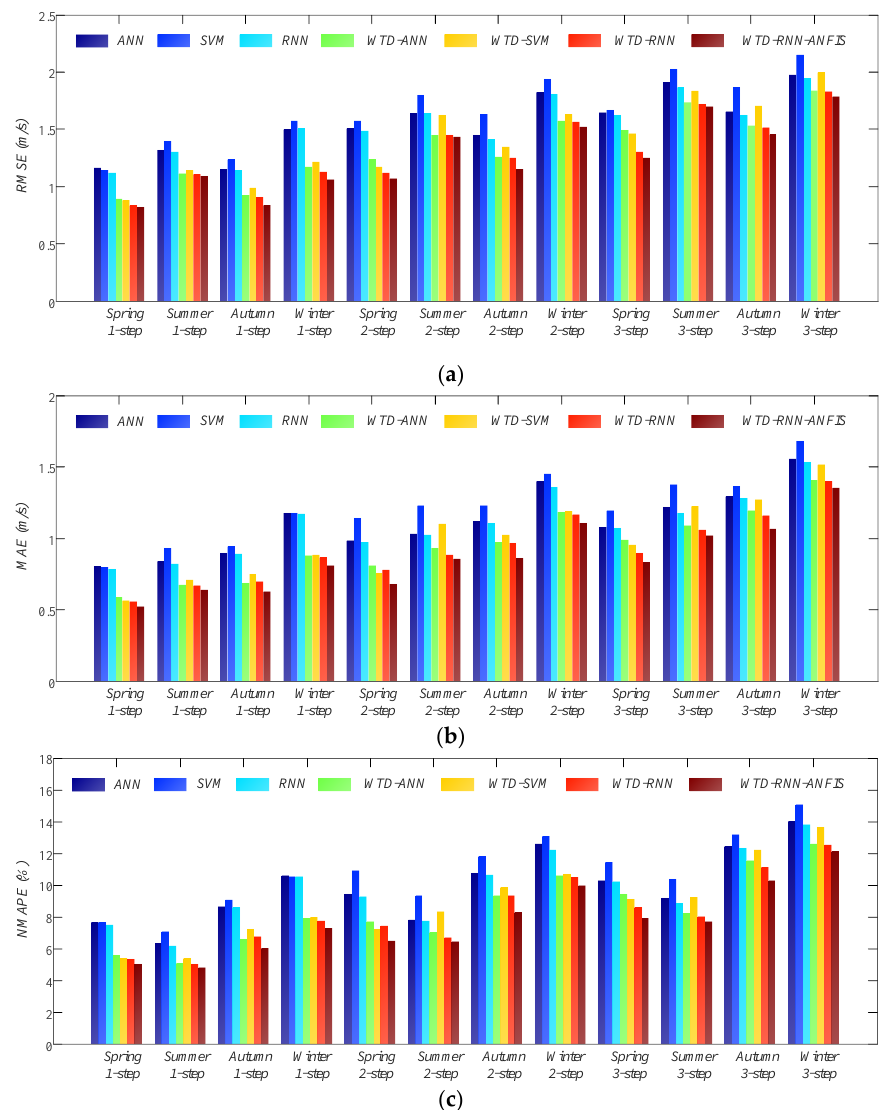
Figure 10. The comparisons of performance criteria for point wind speed forecasting. ( a ) RMSE; ( b ) MAE; ( c ) NMAPE.